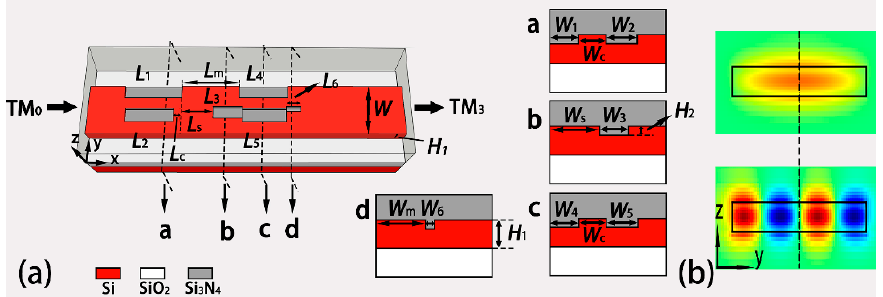
Figure 1. ( a ) Schematic diagram of the proposed TM 0 -to-TM 3 mode-order converter based on the shallowly etched slot metasurface. Insets show the cross-sectional views of the device along its four key positions (marked by a, b, c, d) and the structural parameters are labeled. ( b ) The electric field patterns (dominant component: E z ) of TM 0 and TM 3 mode in the y – z cross section.